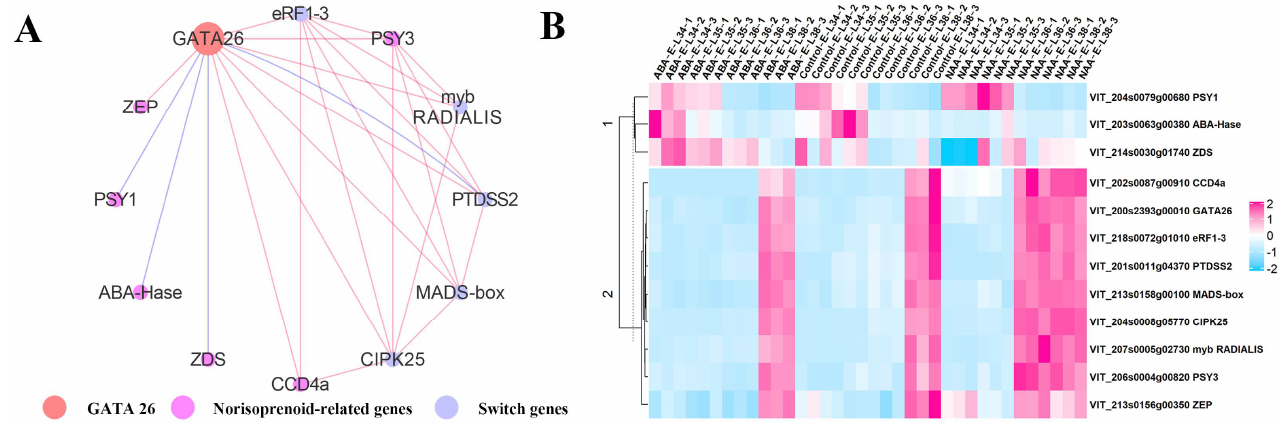
Figure 7. Gene co-expressed and regulatory network. ( A ) Gene co-expressed and regulatory network related to norisoprenoid biosynthesis. The size of the nodes corresponds to the nodes ‘betweenness centrality’, which measures how often a node in the network occurs on all shortest paths between two nodes and help identify the gene that plays a ‘bridge spanning’ role in the network. Red and blue edges indicate that the interaction between two genes is identified by WGCNA and DNA affinity purification sequencing (DAP)-seq, respectively. ( B ) Hierarchical cluster analysis of genes in the left graph. The colors of the boxes represent the intensity of the normalized gene.